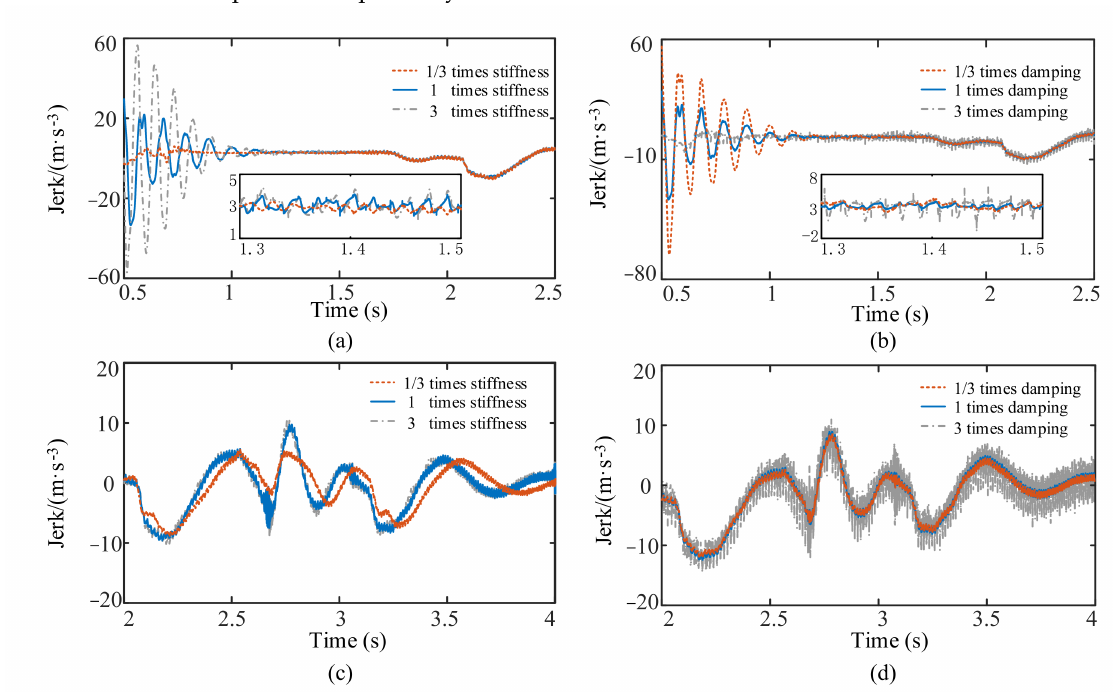
Figure 9. The results of different parameters of the mount on starting and shifting: ( a ) influence of different stiffness during starting; ( b ) influence of different damping during starting; ( c ) influence of different stiffness during shifting; ( d ) influence of different damping during